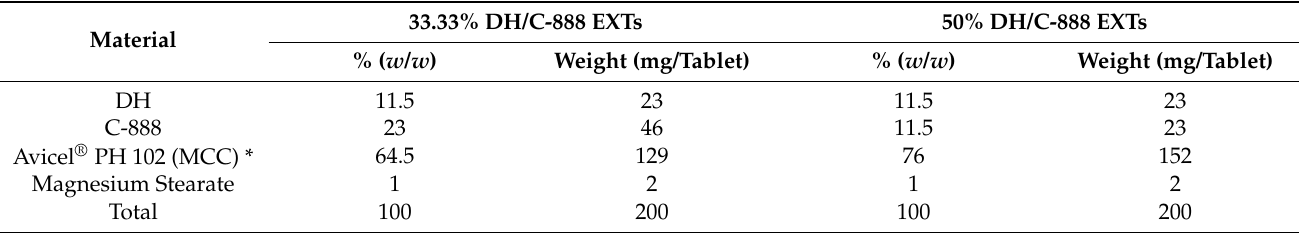
Table 6. Tablet compositions for conventionally processed, 200 mg